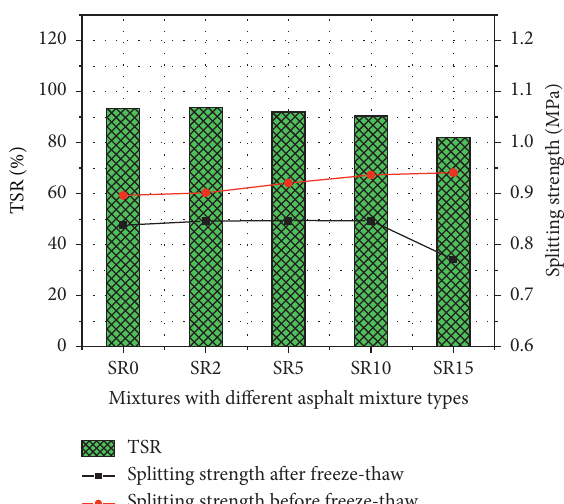
Figure 10: Dynamic stability and rutting depth of different asphalt